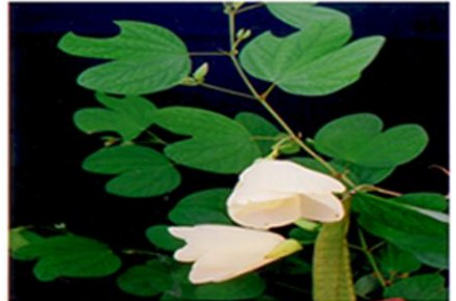
Figure 1. Bauhimia fomentosa. L.showimg its macroscopic